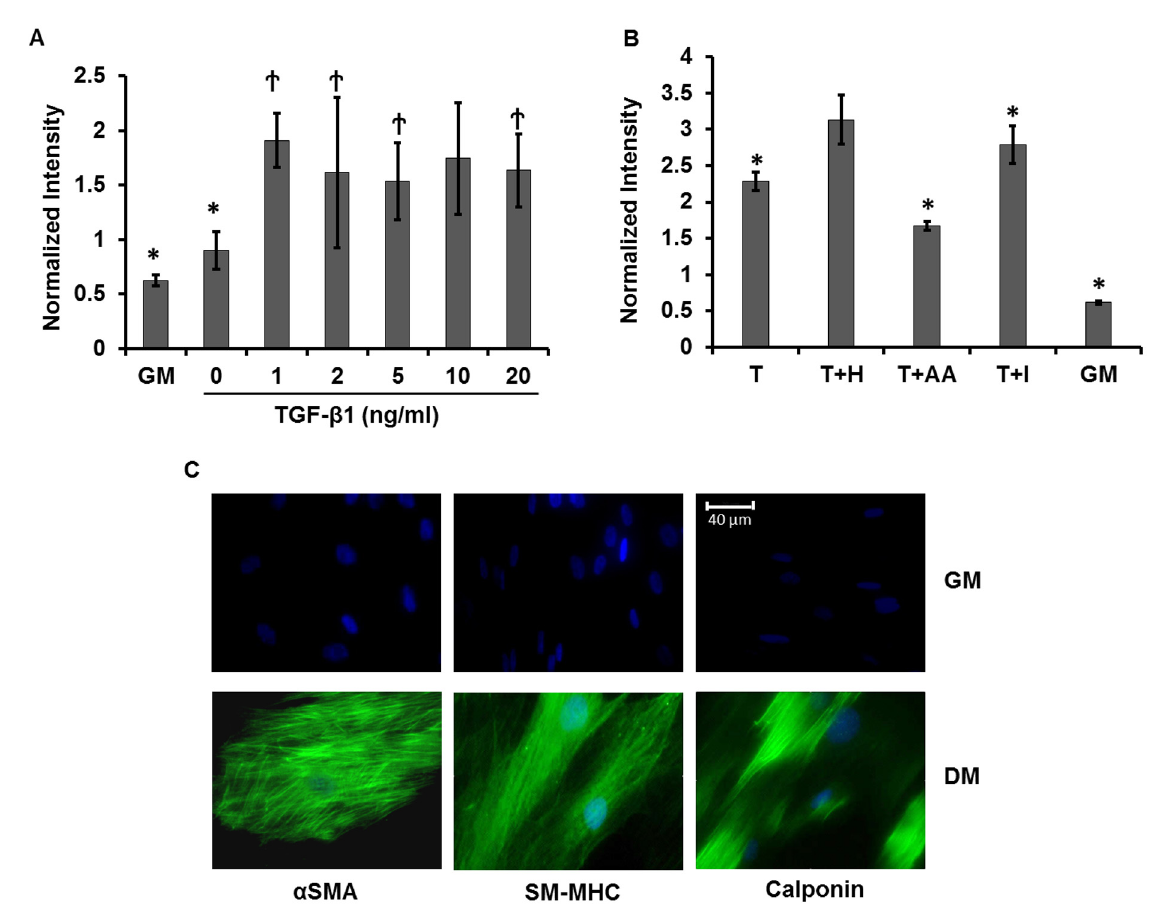
Fig 2. Optimal conditions for myogenic differentiation. Optimized myogenic differentiation medium was determined by treating LVDP-pACTA2-ZsGreen transduced hBM-MSCs with (A) varying concentrations of TGF- β 1 (0, 1, 2, 5, 10, and 20 ng/ml) or (B) a combination of 10 ng/ml TGF- β 1 (T) and one of the following soluble factors: 30 μ g/ml Heparin (H), 30 μ M Ascorbic Acid (AA), or 2 μ M Insulin (I). Red and green fluorescence intensities were measured by flow cytometry after 2 days and normalized intensity was shown. (A) * denotes p < 0.05 as compared to 10 ng/ml TGF- β 1, Ϯ denotes p > 0.05 as compared to 10 ng/ml TGF- β 1. (B) * denotes p < 0.05 as compared to T+H. (C) Immunostaining for SMC proteins ( α SMA, smooth muscle myosin heavy chain (SM-MHC) and Calponin) under GM or the optimized differentiation medium (DM, T+H) for 7 days. Cell nuclei were counterstained with the Hoechst 33342. Images are representative of three independent experiments. Scale bar: 40 μ m.